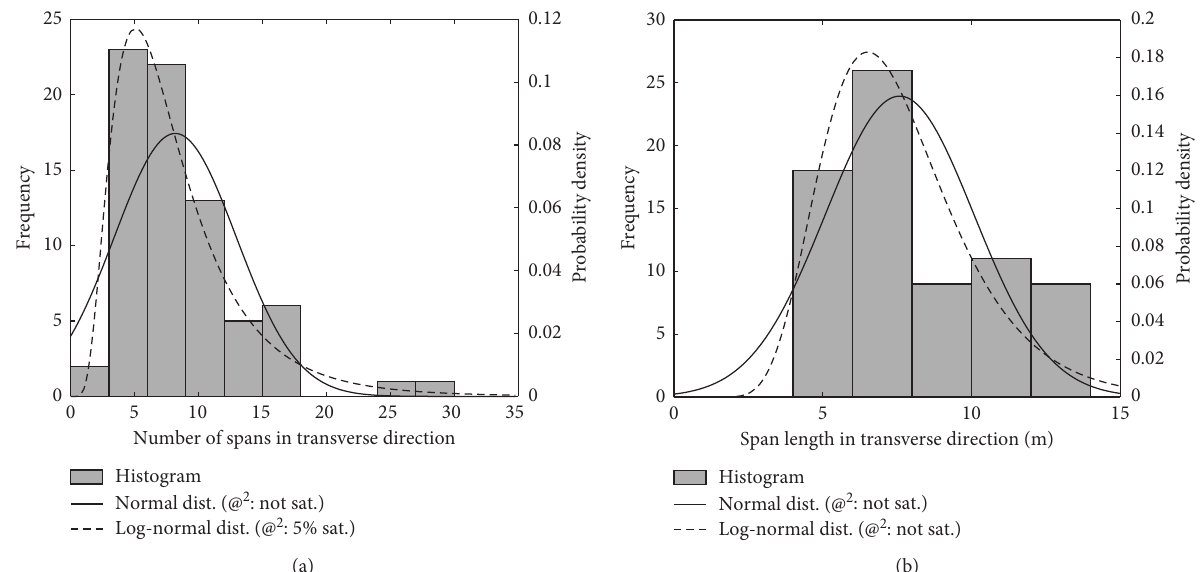
Figure 14: Histogram and probability distributions associated with the (a) number and (b) length of the spans (in the transverse